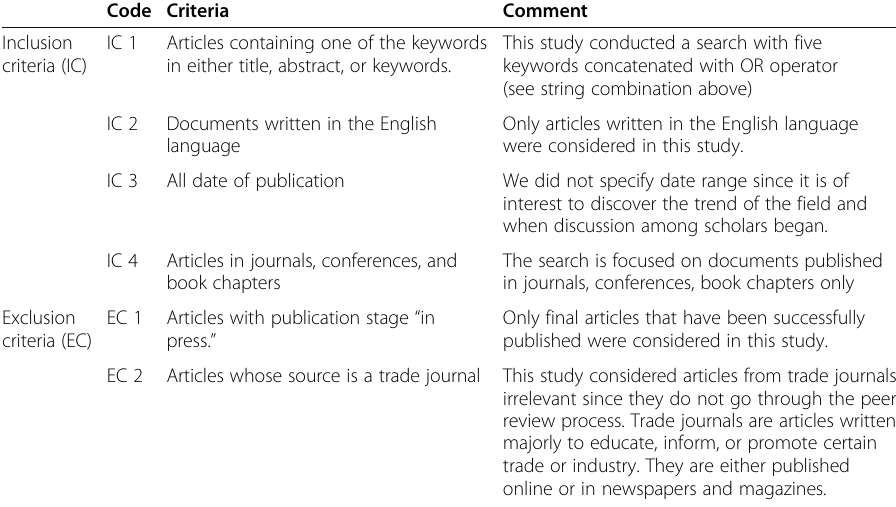
Table 1 Inclusion and exclusion criteria for retrieving the